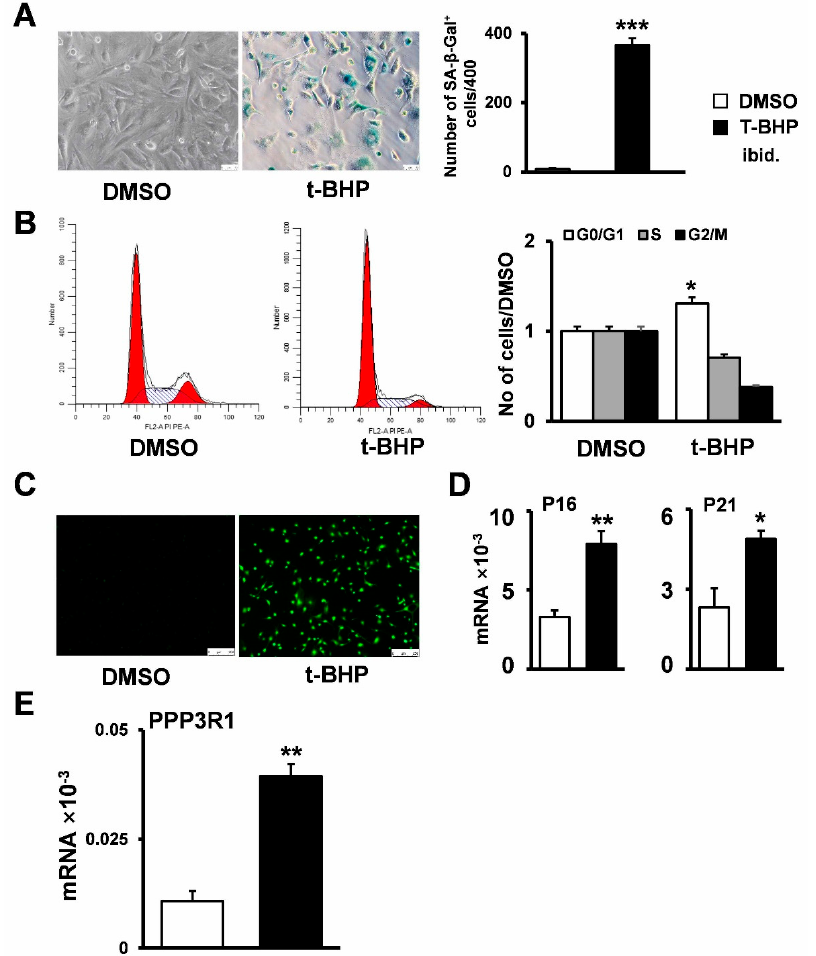
Figure 2. Tert-butyl hydrogen peroxide induced senescence in C3H10T1/2 cells. Cell senescence Fig 2. Tert ‐ Butyl Hydrogen Peroxide Induced Senescence in C3H10T1/2 Cells. Cell senes ‐ status was evaluated by ( A ) cell senescence β -galactosidase staining, ( B ) cell cycle detection, ( C ) ROS cence status was evaluated by (A) Cell senescence β‐ galactosidase staining (B) cell cycle de ‐ staining, and ( D ) qPCR after tert-butyl hydroperoxide treatment of cells for 6 h. ( E ) The mRNA tection (C) ROS staining (D) qPCR after tert ‐ butyl hydroperoxide treatment of cells for 6 expression of PPP3R1 was detected by qPCR. * p < 0.05. ** p < 0.01. *** p < 0.001. ( B ) red areas: G0/G1 hours. (E) mRNA expression of PPP3R1 detected by qPCR. * p < 0.05. ** p < 0.01. and G2 phase; ( B ) shadow areas: S phase. (Scale bars: ( A ) 20 × , ( C ) 20 ×